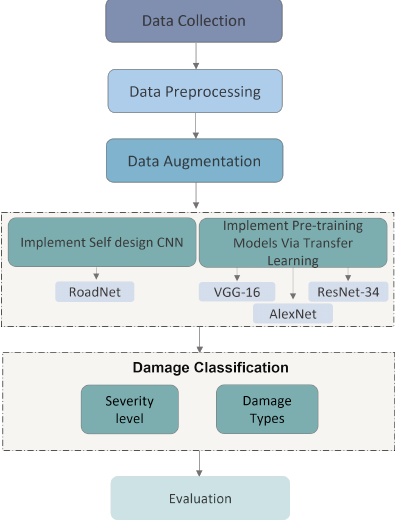
Figure 3. Steps of our proposed